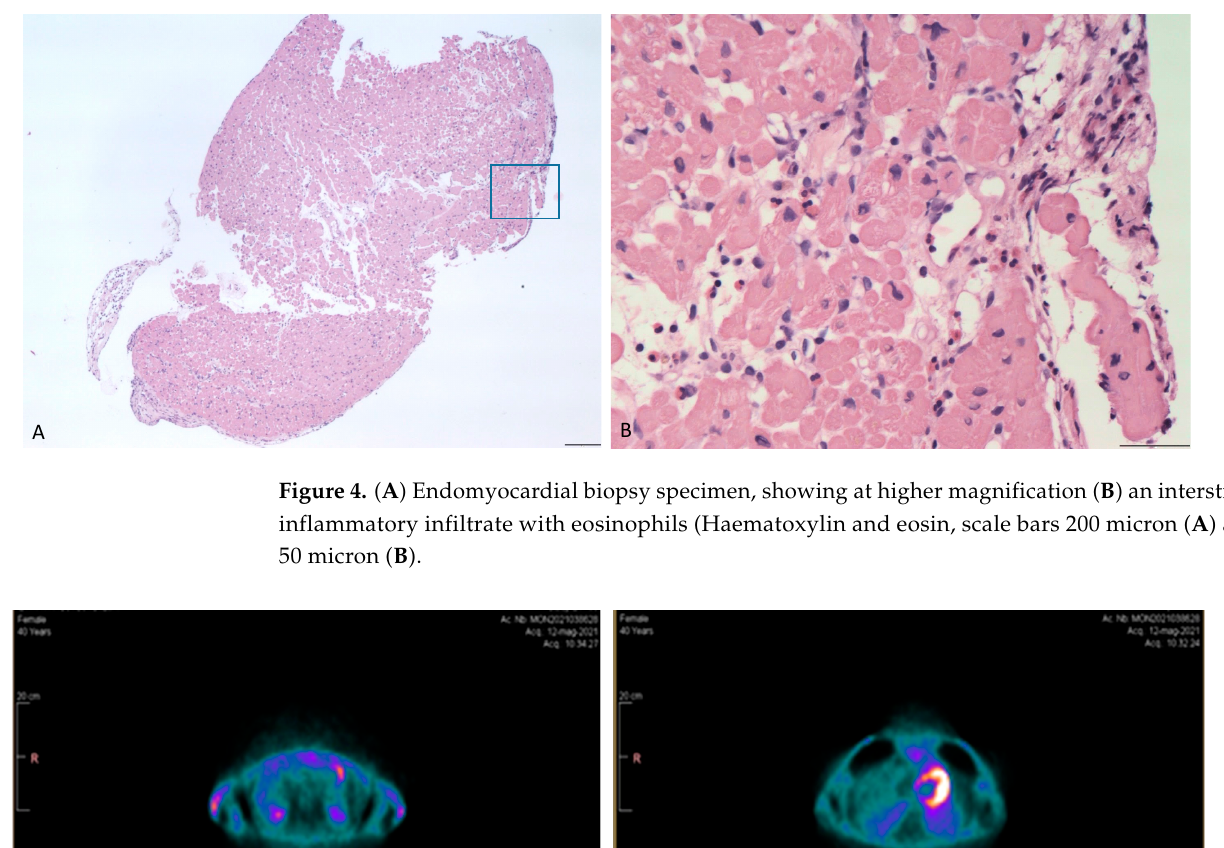
Figure 4. ( A ) Endomyocardial biopsy specimen, showing at higher magnification ( B ) an interstitial inflammatory infiltrate with eosinophils (Haematoxylin and eosin, scale bars 200 micron ( A ) and 50 micron ( B ).